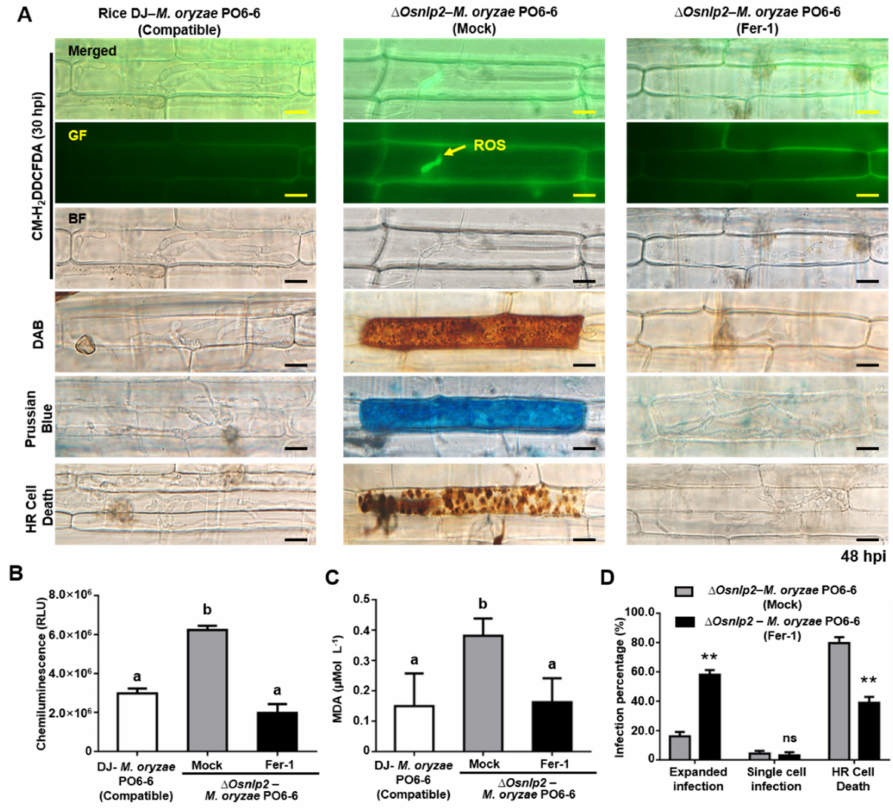
Figure 5. The small-molecule ferroptosis inhibitor ferrostatin-1 (Fer-1) suppresses the accumulation of ROS and ferric ions, lipid peroxidation, and HR cell death in ∆ Osnlp2 leaf sheaths infected with virulent Magnaporthe oryzae PO6-6. ( A ) Inhibition of ROS and ferric ion accumulation and HR cell death in infected rice cells treated with 10 µ M ferrostatin-1. Leaf sheaths of rice DJ and ∆ Osnlp2 mutant line #4-2 were inoculated with M. oryzae PO6-6. ROS accumulation was detected by CM-H 2 DCFDA and DAB staining, and ferric ion (Fe 3+ ) accumulation was visualized by Prussian blue staining. The images shown were taken using a fluorescence microscope (Zeiss equipped with Axioplan 2) with bright field or GF filters (Ex/Em: 488 nm/505–550 nm wavelengths). BF, bright field; GF, green fluorescence; hpi, hours post inoculation. Scale bars = 10 µ m. ( B ) ROS quantification in infected rice leaf sheaths treated with 10 µ M ferrostatin-1. ROS quantities in rice cells were determined by a chemiluminescence assay. Values are means ± SD of relative luminescence units (RLU) ( n = 10) from different rice sheath discs. ( C ) Determination of lipid peroxidation levels in infected rice sheaths treated with 10 µ M ferrostatin-1. Lipid peroxidation was determined by quantifying malondialdehyde (MDA). The values are presented as means ± SD ( n = 4) of MDA concentrations in leaf sheaths from different plants. ( D ) Quantification of infection types in rice leaf sheaths treated with 10 µ M ferrostatin-1. The cell numbers of different infection types were counted at 48 hpi using a light microscope. The percentages of infected cells are presented as means ± SD from the cell numbers of infection types in rice sheaths of different plants ( n = 4). Different letters above the bars indicate significantly different means as determined by the least significant difference (LSD) test ( p < 0.05). Asterisks above the bars indicate significant differences as determined by Student’s t -test ( p <